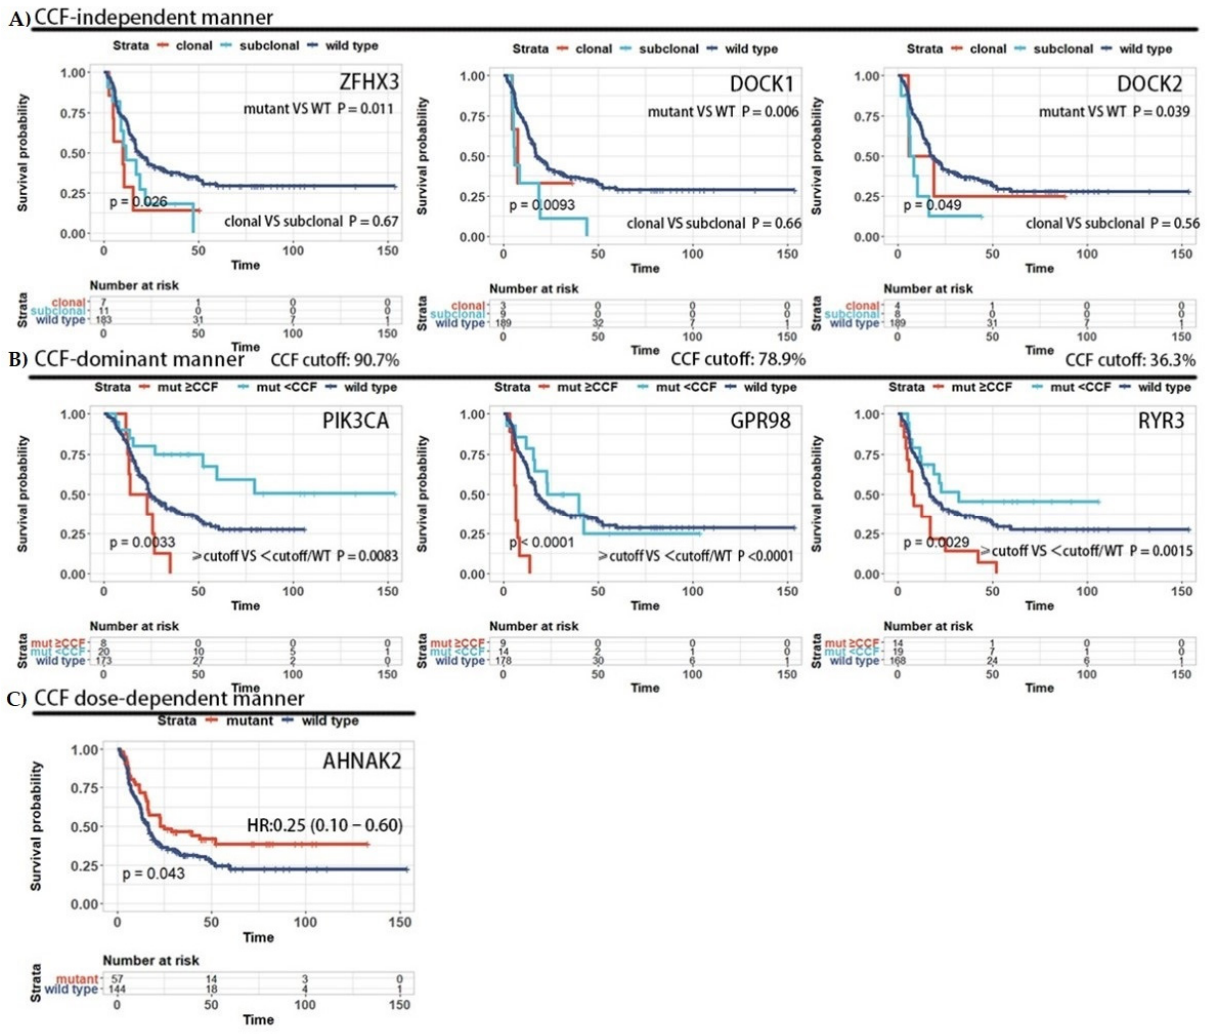
Figure 2. CCF–based patterns of prognostic value. The clinical endpoint analyzed here was DFS. Three prognostic effect patterns were identified by on our classification pipeline: CCF-independent pattern ( A ), CCF–dominant pattern ( B ) and CCF dose–dependent pattern ( C ).